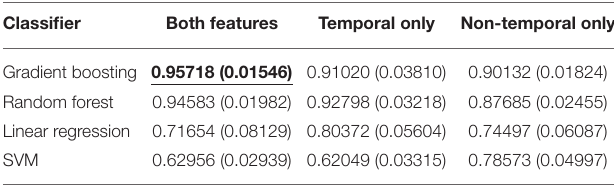
TABLE 2 | Average and standard deviation (SD) of AUC-ROC score for mortality prediction using shallow classifiers with temporal features only, non-temporal features only, and both types of features.